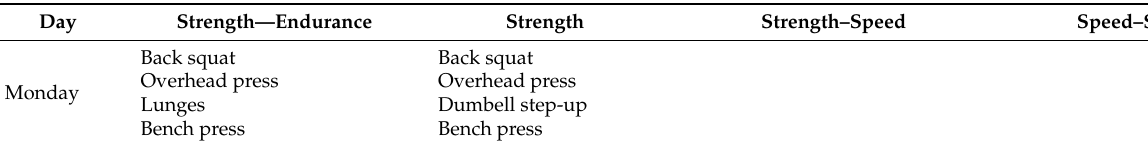
Table 2. Resistance training program and organization.